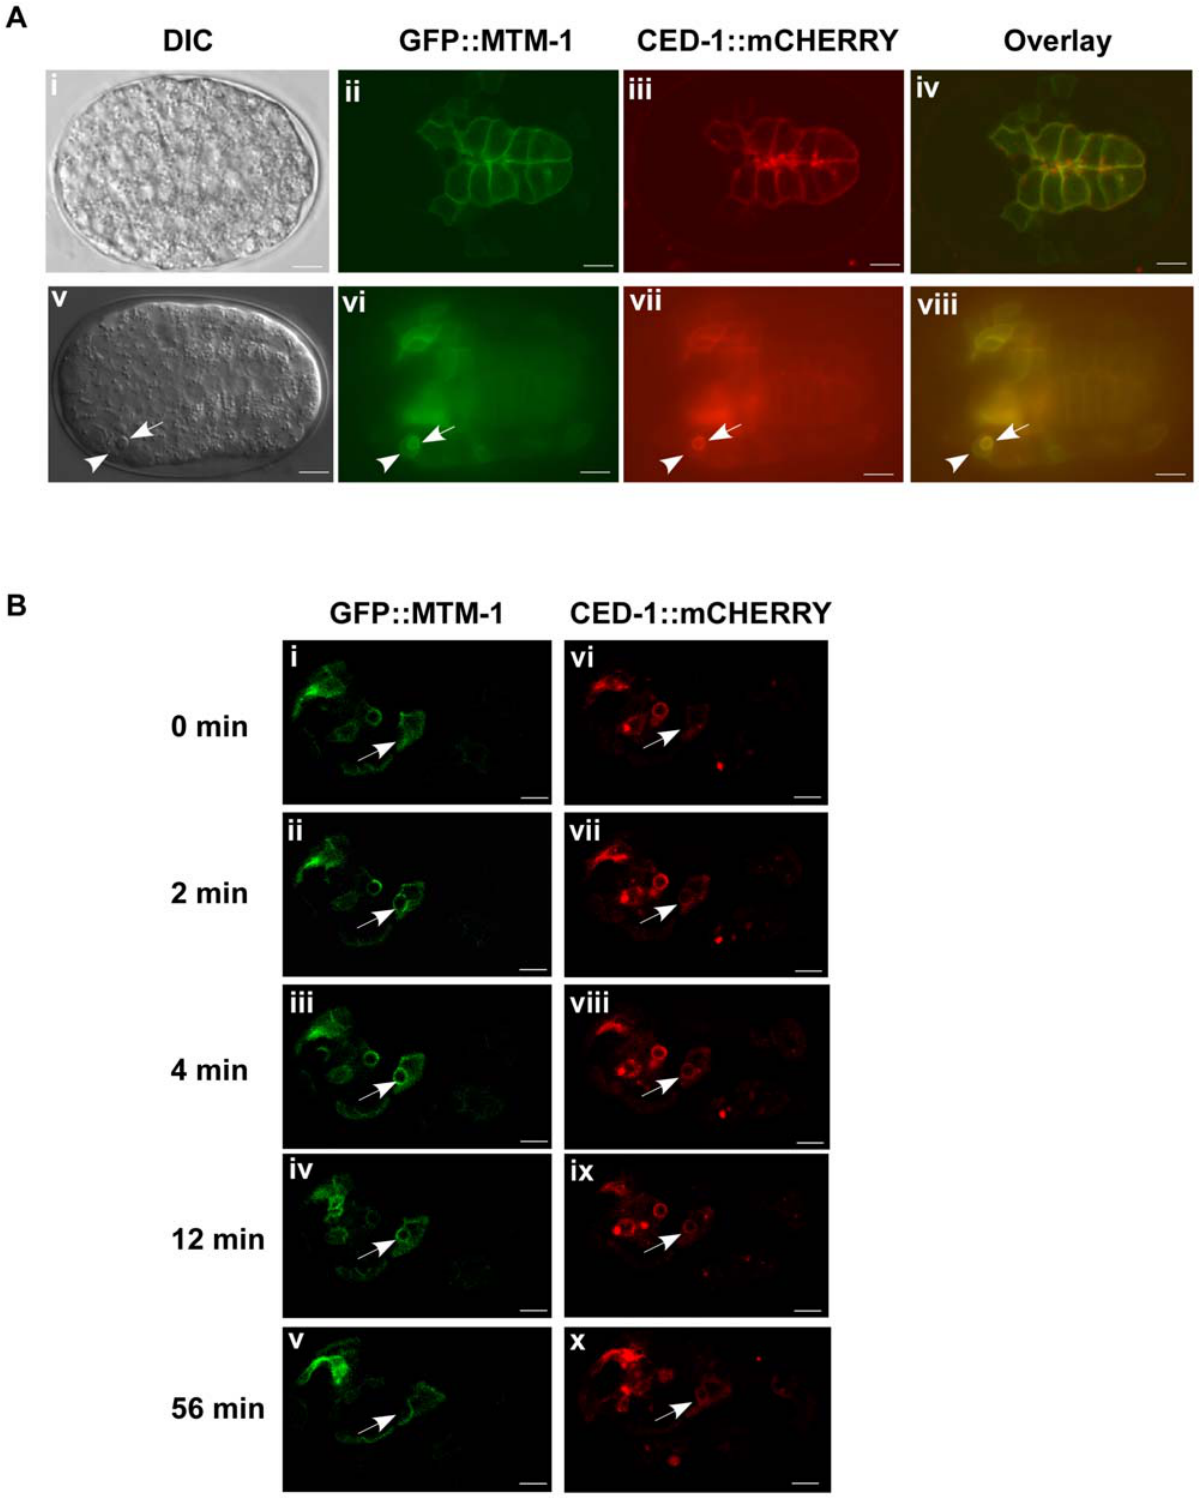
Figure7.MTM-1 andCED-1 co-localize to apoptoticcells. (A) DICand fluorescence images ofa wild-typeembryoexpressingbothGFP::MTM-1and CED-1::mCHERRY controlled by the ced-1 promoter are shown. MTM-1 and CED-1 co-localize to the plasma membrane (i–iv) and are clustered around the same apoptotic cell (arrow) internalized by the neighboring engulfing cell (arrowhead) (v–viii). Bars: 5 m m. (B) MTM-1 transiently associates with the apoptotic cellduring engulfment.Confocal time-lapseimagesofa wild-type embryoco-expressingP ced-1 gfp::mtm-1 (i–v) and P ced-1 ced-1::mcherry (vi–x)are shown. The apoptotic cell followed is indicated by the arrow and the time point immediately prior to the appearance of GFP::MTM-1 or CED-1::mCHERRY was set as 0 min. The longer duration of the apoptotic cell is likely caused by overexpression of GFP::MTM-1. Bars: 5 m m.